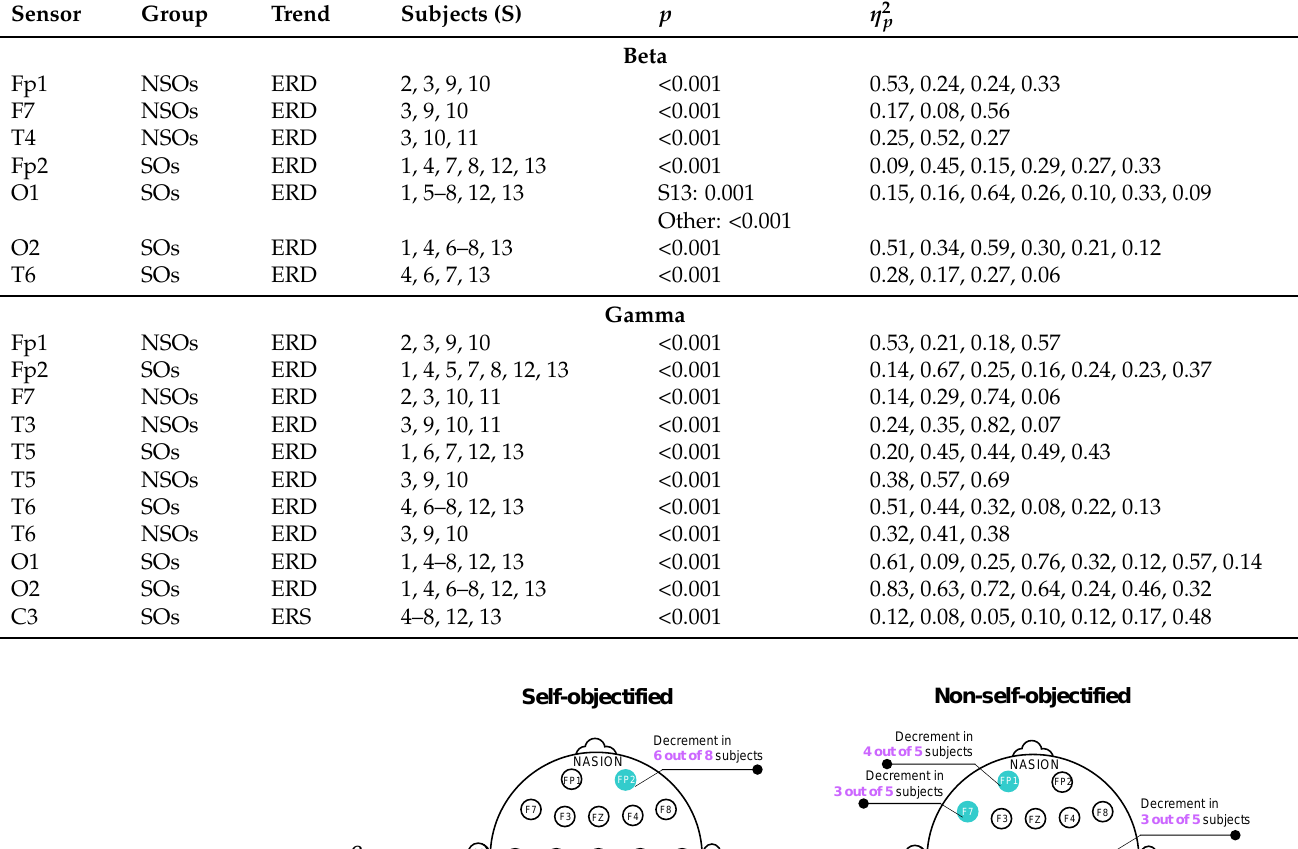
Table 2. ERS changes that are presented in the majority of the SOs or NSOs.